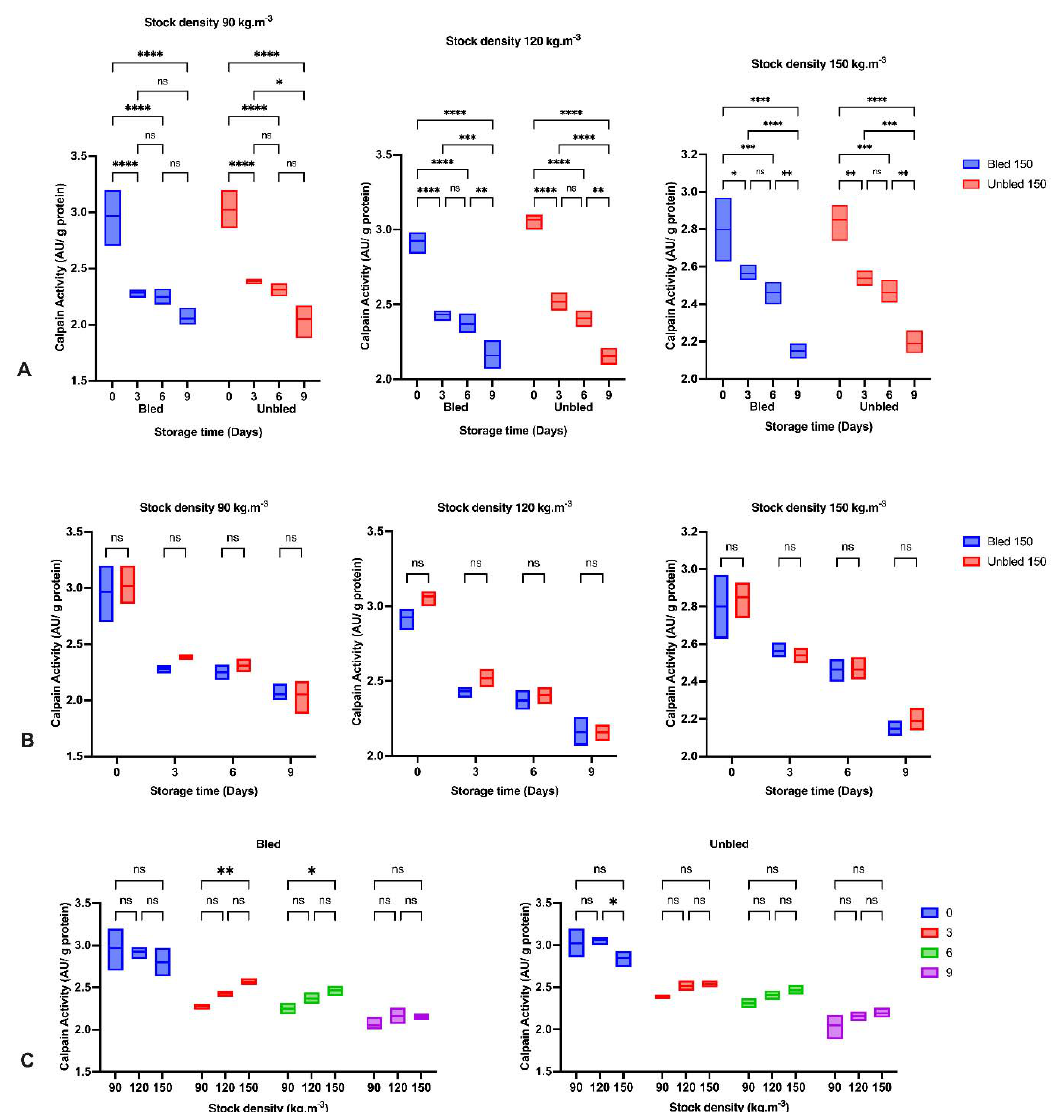
Figure 1. Calpain activity: ( A ) During the storage time (0, 3, 6 and 9 Days) in bled and un ‐ bled groups at different stock densities (90, 120 and 150 kg.m _3 ); ( B ) In bled and un ‐ bled groups at each storage time (0, 3, 6 and 9 Days) and at different stock densities (90, 120 and 150 kg.m _3 ); ( C ) In different stocking densities (90, 120 and 150 kg.m _3 ) during storage time (0, 3, 6 and 9 Days) in bled and un ‐ bled groups; ( p < 0.05, Tukey’s multiple comparisons test; ns: non ‐ significant; * p < 0.05; ** p < 0.01; *** p < 0.001; **** p < 0.0001). Box plots showing line at mean. Box plots showing the line at upper quartile, lower quartile and at the mean.